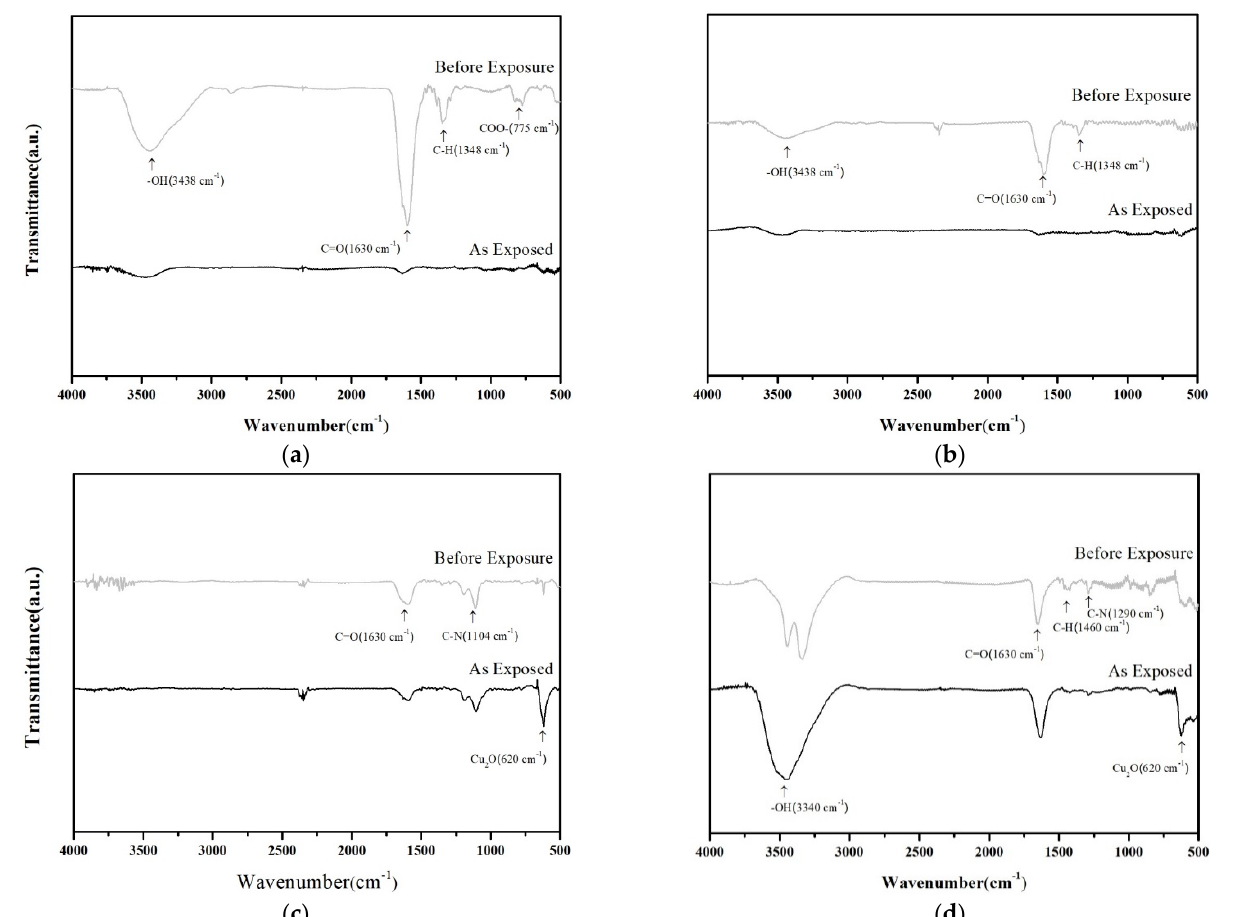
Figure 7. FTIR spectra of sintered structures obtained from hybrid pastes with various copper salts, and numbers of the flashes: ( a ) copper formate with four pulses, ( b ) copper acetate with three pulses, ( c ) cupric sulfate with three pulses, ( d ) cupric chloride with four pulses.